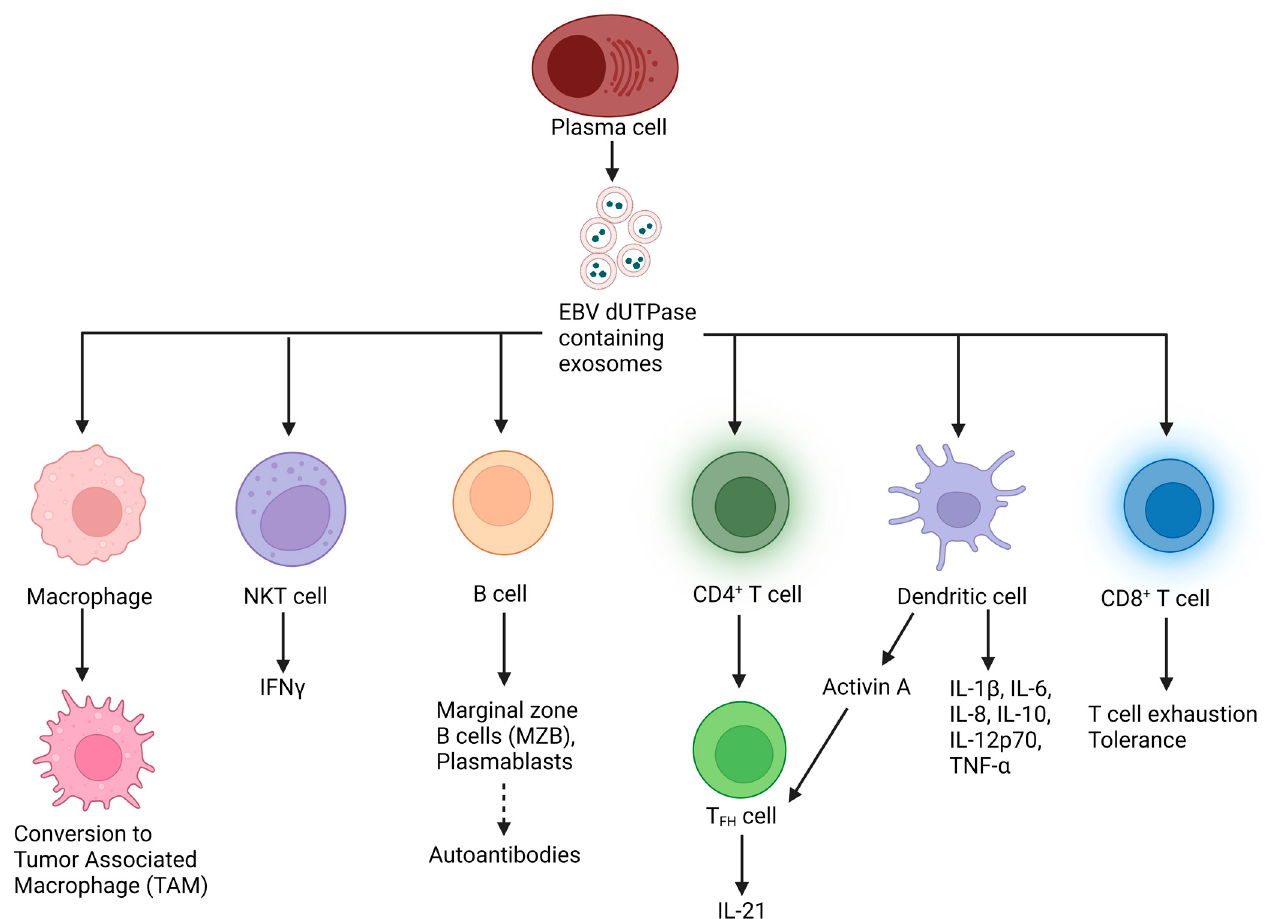
Figure 4. Potential roles of EBV dUTPase in modulating the TME through activation of immune cells (DCs, macrophages, NKT) and secretion of proinflammatory cytokines, promoting TAM formation, T cell exhaustion, aberrant germinal center T FH function, and polyreactive antibodies production, which together can contribute to the TME and promote tumor progression. Dashed arrow represents an unproven process.